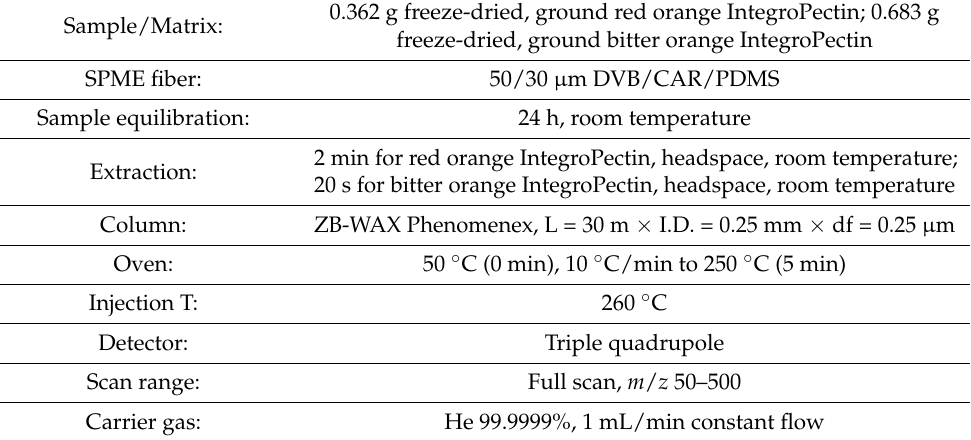
Table 1. Conditions employed for the SPME-GC/MS